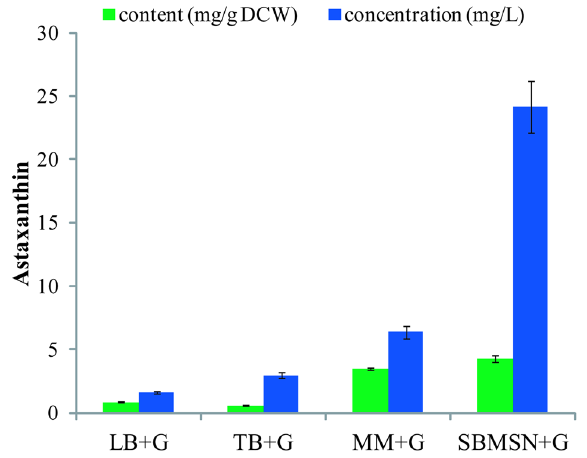
Fig. 5 Astaxanthin production of E. coli DH5 a transformants (pCm- GadEp-AS) cultivated in different media. Data represent averages from three or more replicate cultures; error bars show standard